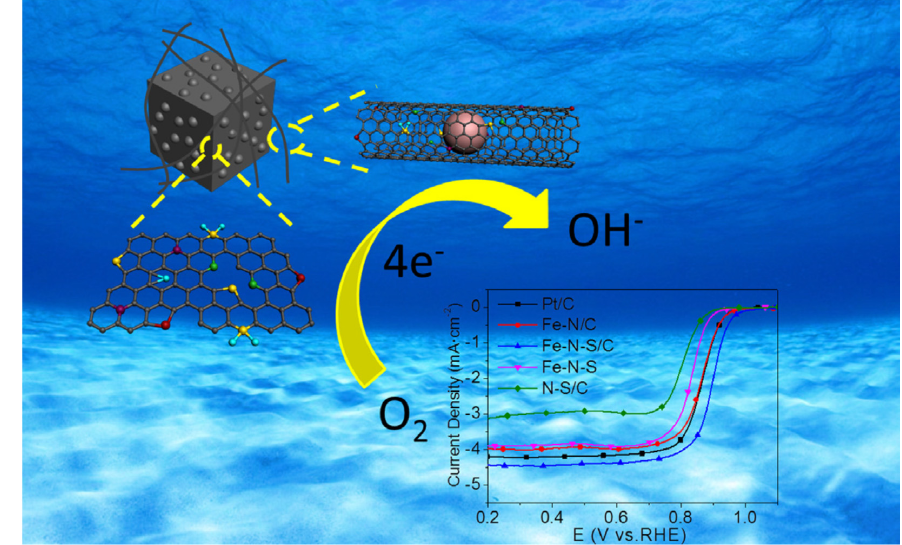
Figure 1. Illustration representing an hybrid of Fe 3 C@N,S co-doped carbon nanotubes coated porous carbon as a superior catalyst toward oxygen reduction reaction (ORR) for fuel cell. In insert: typical ORR polarization curve for various Fe-containing carbonaceous and Pt / C catalysts. Reprinted with permission from ref [26]. Copyright (2019)